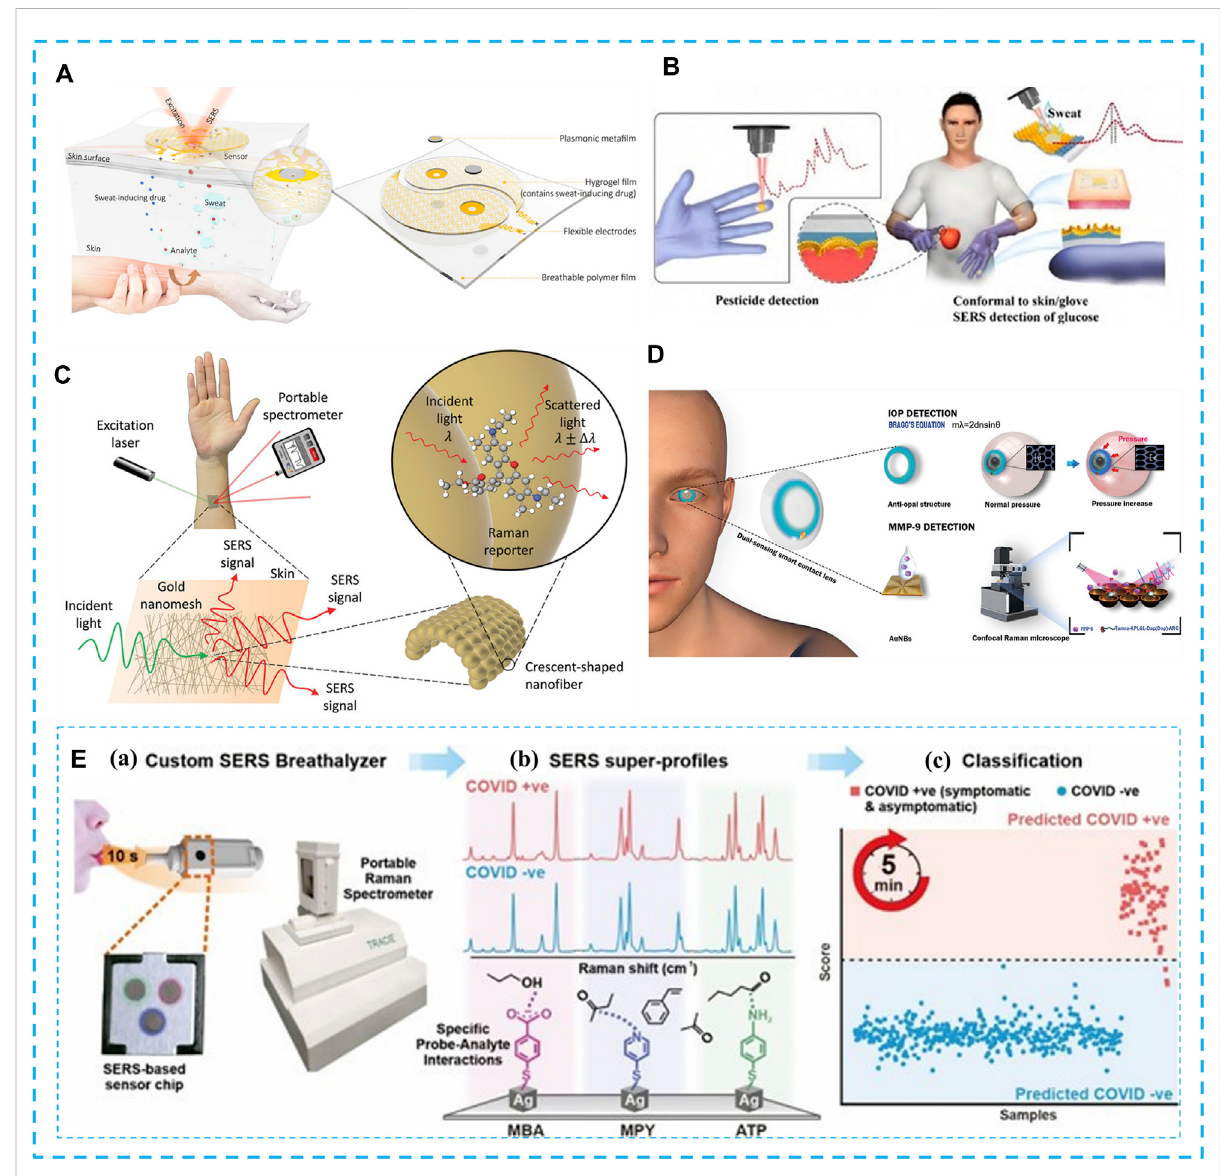
FIGURE 2 SERS non-invasive medical diagnosis. (A) Schematic diagram of the working principle and design of the plasma metamaterial integrated wearable SERS sensing device, consisting of two main components (sweat extraction component and SERS sensing component) with the appearance of a yin and yang symbol. Copyright © 2021, American Association for the Advancement of Science. (B) Ultra-thin fl exible SF-AAO-Au substratepesticidedetectionlabglovesandsweatglucosedualfunctionwearableSERSsensor.Copyright © 2022,Elsevier. (C) Conceptdiagram of wearable skin surface SERS. Copyright © 2022, Wiley. (D) Schematic diagram of a bifunctional contact lens sensor consisting of an anti-catenary structure for IOP monitoring and a peptide-functionalized AuNBs SERS substrate for MMP-9 detection. Copyright © 2022, Wiley. (E) Overview of SERS-based strategy for identifying covid-positive individuals using respiratory volatile organic compounds (BVOCs): (A) . Breath testing using a handheld surface-enhanced Raman scattering-based breath detector for 10s blowing; (B) . Chemical interaction with BVOCs using MBA, MPY, and ATP as molecular receptors to bring gaseous analytes close to the plasma surface; (C) . Receive test results within 5 min. Copyright © 2022 American Chemical